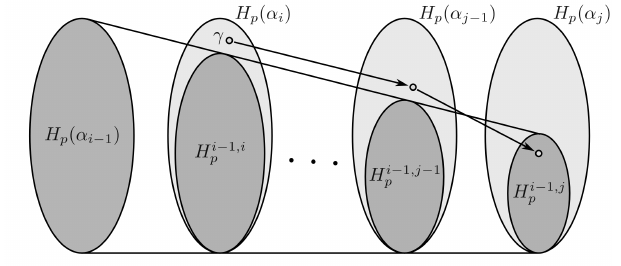
Figure 15: An illustration of the definitions of birth and death of homology